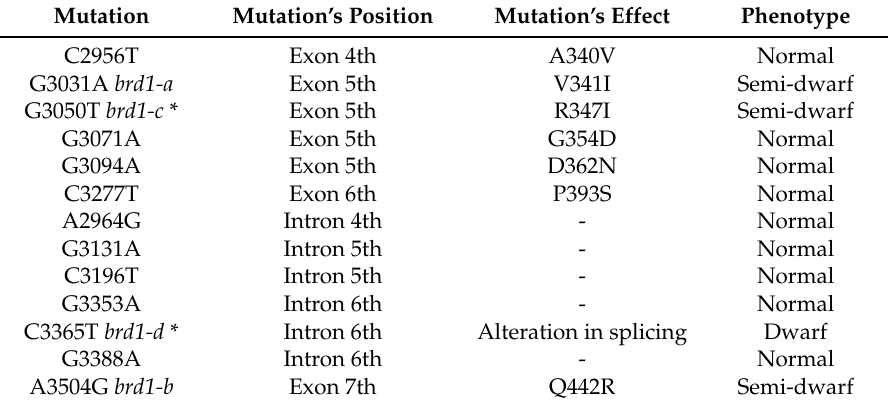
Table 1. The mutations identified within the HvDWARF gene with the TILLING approach and their phenotypic effect in homozygous mutant plants. Asterisks (*) indicate the alleles described in details in the text. The previously identified alleles brd1-a and brd1-b are also included.